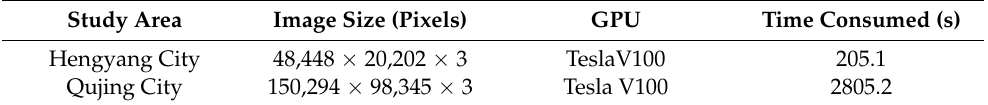
Table 9. Accuracy assessment.